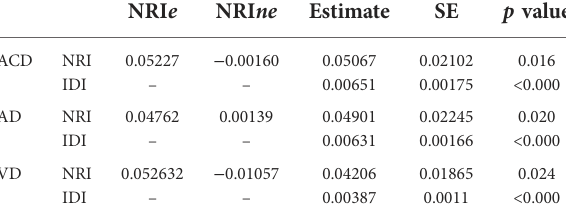
TABLE 4 Net reclassi fi cation improvement (NRI) and integrated discrimination improvement (IDI) for inclusion of